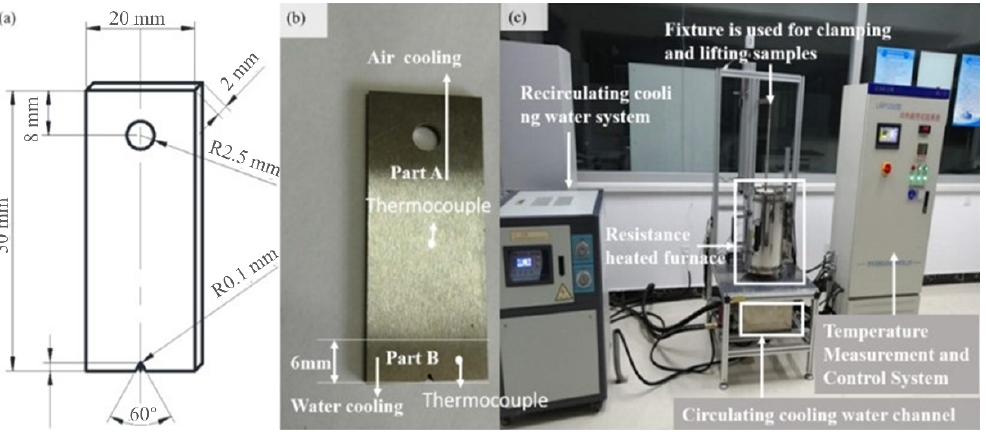
Figure 1. Schematic diagram of dimensions and experimental facilities: ( a ) schematic diagram of dimensions; ( b ) sample pictures; ( c ) thermal fatigue testing apparatus.